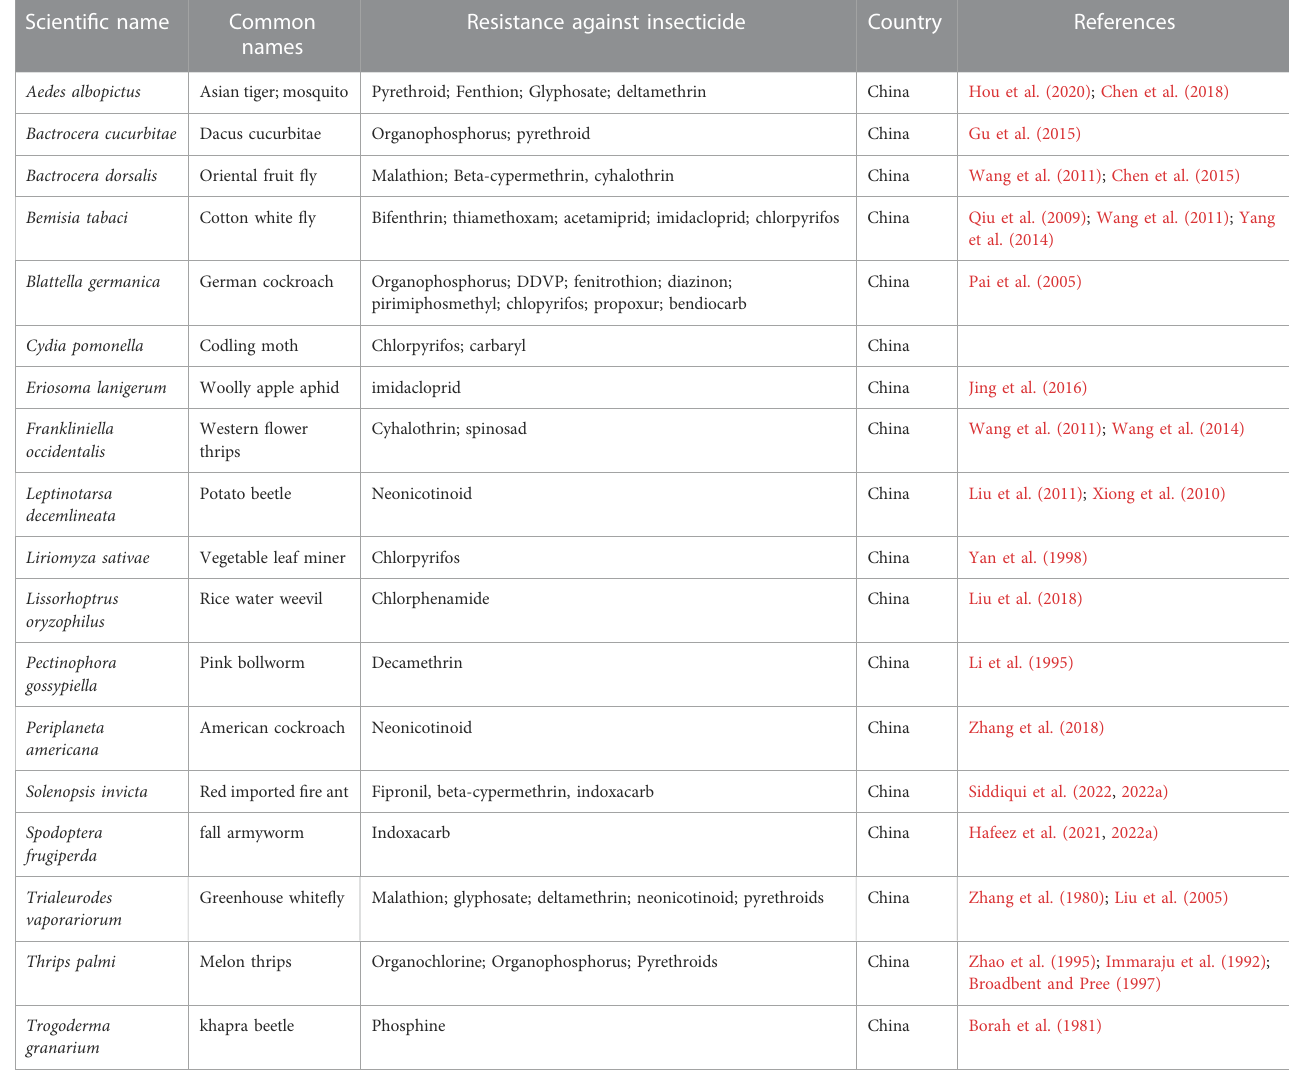
TABLE 1 A list of insecticide-resistant invasive species of China. Scienti fi c